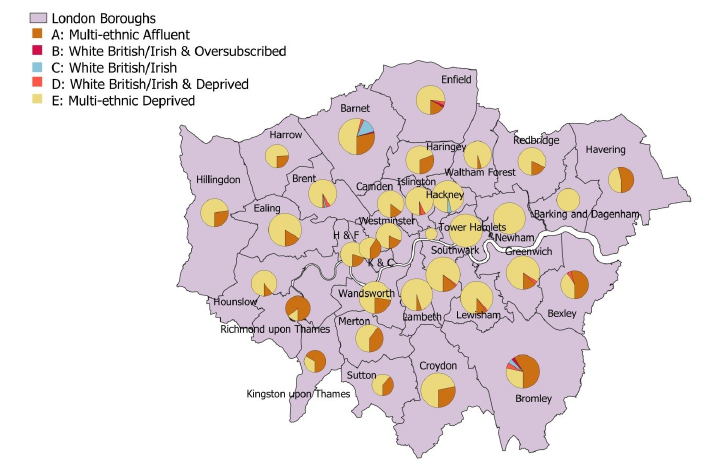
Figure 3: Geographic distribution of groupings by London Borough (H & F : Hammersmith and Fulham and K & C : Kensington and Chelsea)